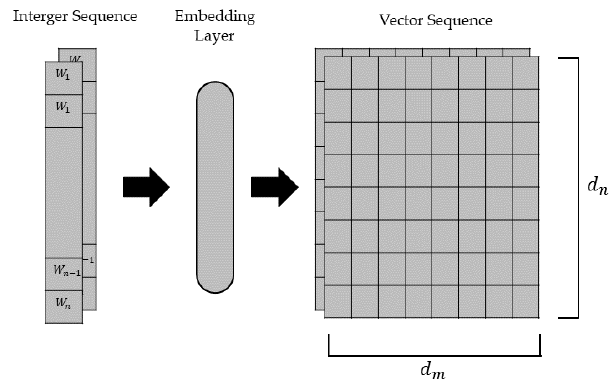
Figure 2. Embedding layer.